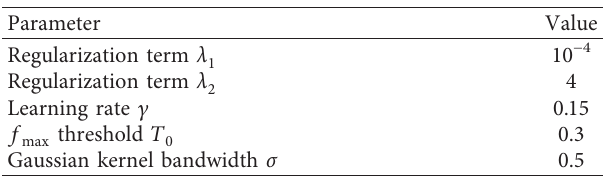
Figure 5: Comparison of OSR and tracking speed on the OTB2015 dataset. The horizontal axes represent the tracking speed, and the vertical axes represent the overlap success rate. (a) Comparison of the efficiency of selecting different features for tracking. (b) Comparison of the efficiency of different Table 1: Parameter settings.